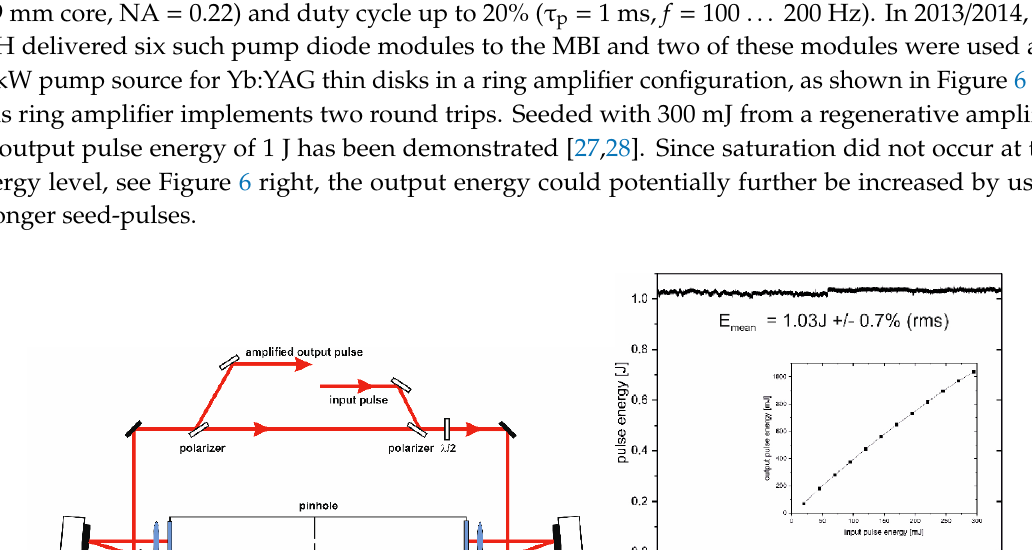
Figure 5. ( Left ) Sketch of the regenerative thin-disk amplifier. ( Right ) Pulse energy as function of time during normal operation. Output pulses with energy of more than 300 mJ and a fluctuation below 0.3% (rms) measured over 2.5 h were demonstrated.